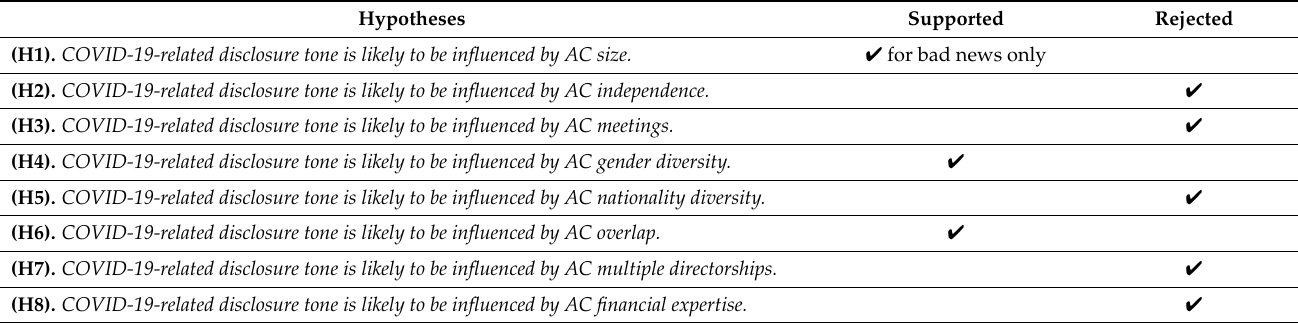
Table 3. Summary of the acceptance/rejection of the research